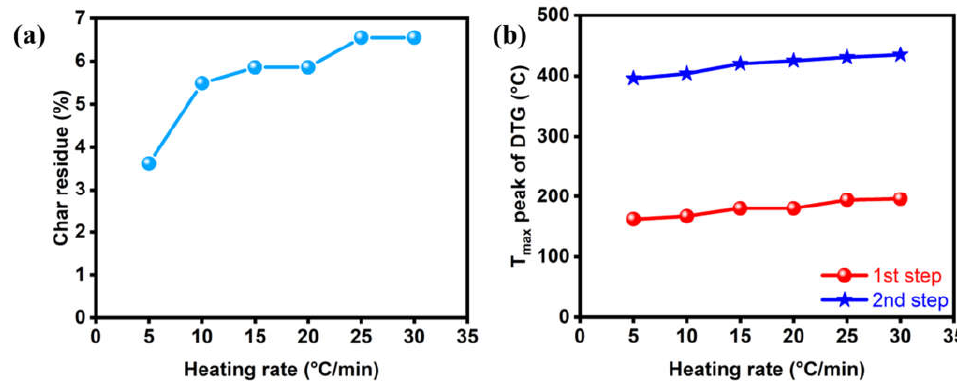
Figure 7. ( a ) Char residue at 550 °C and ( b ) T max peak of DTG of PCL-g-MA at a maximum grafting ratio and degradation temperature as a function of heating rate. The relationships between ln( g ( α )/ T 2 ) and T −1 according to Equation (8) using differ- ential function g(α) from Table 4 are shown in Table 5. The kinetic models were chosen from the linear approximation to be with a high determination coefficient (R 2 ). Table 5 shows model R3 provided the linear trend with a higher determination coefficient (R 2 equals approx. 0.99) than the other models with α from TGA-simulated curves with the spherical symmetry based on the Geometrical Contraction Model (R3) based on the Coats– Redfern method for the reaction of the modification of PCL-g-MA. These models and re- sults indicate the pyrolysis of the PCL-g-MA structure so that the positions of MA grafted on a PCL main chain are more likely to undergo random scissions first due to the weak bonding from C-C structure to produce shorter monomers and generate free radicals of the polymer. After that, the PCL structure starts to degrade by random scissions via cis- elimination reactions and progresses with cyclic rupture via intramolecular transesterifi- cation at over 300 °C [74,81]. The pyrolysis results confirmed the same tendency as sug- gested by the TGA and DTA results in Figure 6. Table 5. Determination coefficient R 2 calculated from kinetic parameters for different models with α values obtained from TGA-simulated curves by the Coats–Redfern equation. Mechanism Models